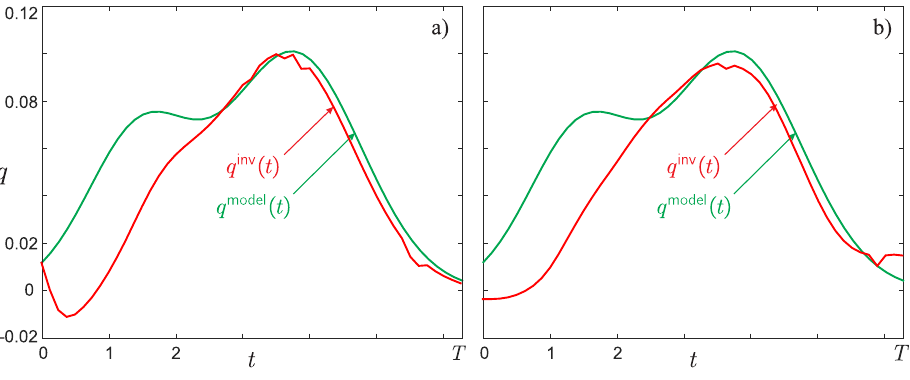
Figure 5. The norm of the residual (cid:107) q inv ( t ) − q model ( t ) (cid:107) L inverse problem data for various ε .